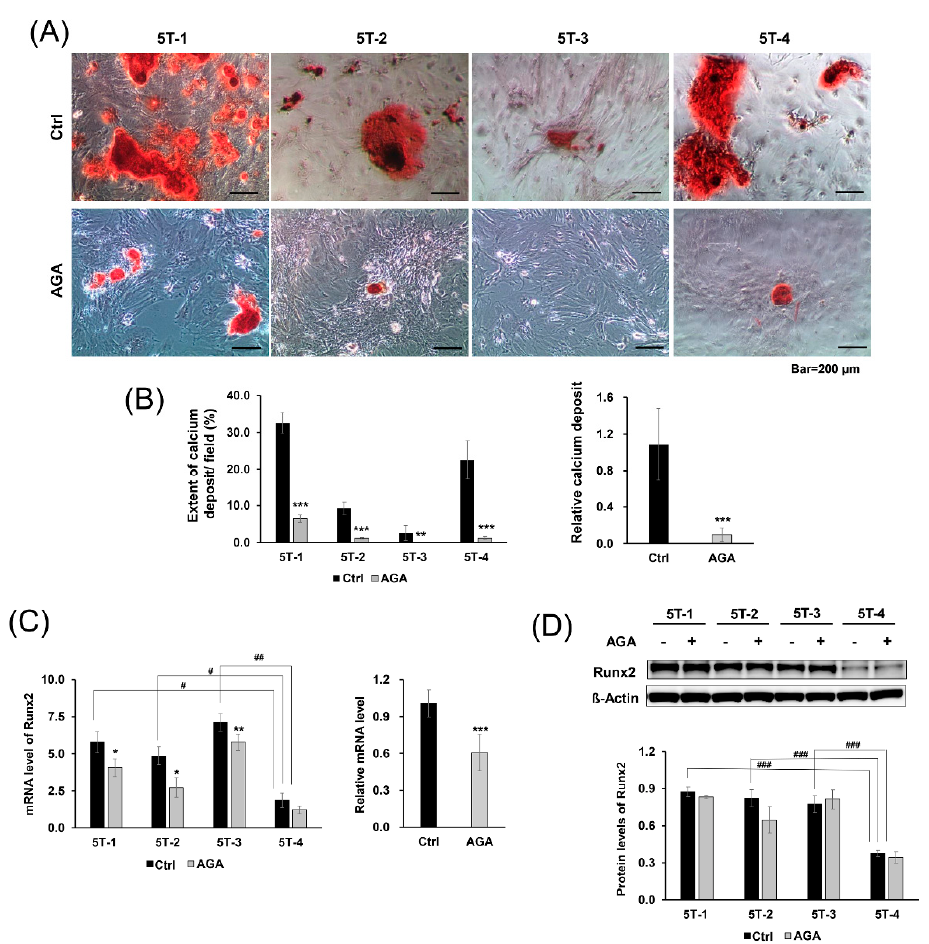
Figure 2. Effect of AGA on osteogenesis. ( a ) Representative microscopic images of TDSCs cultured with and without AGA for 21 days. TDSCs were incubated with 2% Alizarin Red S staining solution and ( b ) extent of calcium deposit per field measured stained areas using ImageJ. The relative calcium deposit represents the value divided the extent of calcium deposit in the AGA treatment group by the extent of calcium deposit in the control group in all of the cells. Calcium deposits were decreased in the presence of AGA. AGA effects on the expression of Runx2 were measured by ( c ) qRT-PCR and ( d ) Western blot. ( c ) qRT-PCR analysis showed decreased mRNA levels of Runx2 in the presence of AGA, ( d ) whereas Western blot analysis presented no significant change in protein levels of Runx2. The relative mRNA level represents the value divided Runx2 mRNA level of the AGA treatment group by Runx2 mRNA level of the control group in all of the cells. mRNA level of Runx2 represents mRNA expression levels standardized to β -actin, and protein level of Runx2 represents normalized protein expression level by β -actin. Error bars represent the standard deviation of mean. * p < 0.05, ** p < 0.01, *** p < 0.001, compared with AGA group and control group. # p < 0.05, ## p < 0.01, ### p < 0.001, compared with 5T-4 cell and other cells.